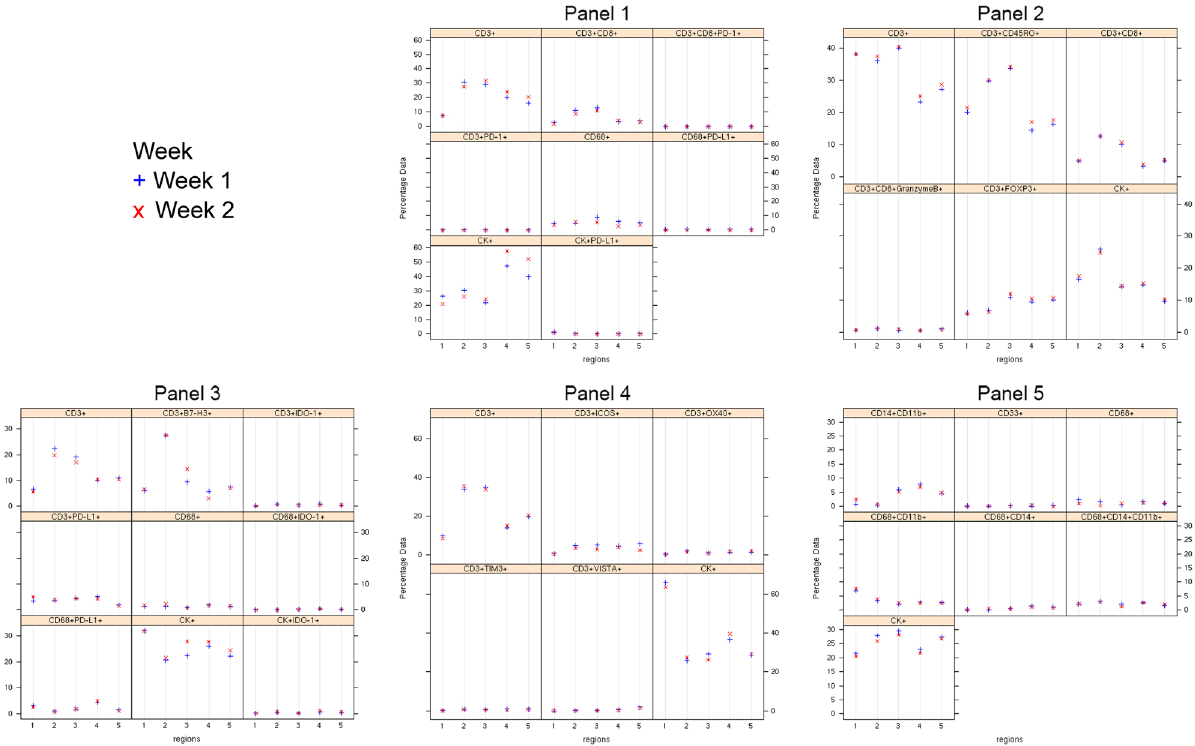
Figure 2. Trellis plots of percentage data from a representative case (ADC-1) by region and week. The blue dots represent week 1 and the red dots represent week 2, visualizing the consistency between the 2 weeks for each cell phenotype obtained by dividing the cell phenotype studded by the total number of cells. The Supplementary Figs. 9 to 13 show the rest of the samples analyzed. The images were generated using R studio software version